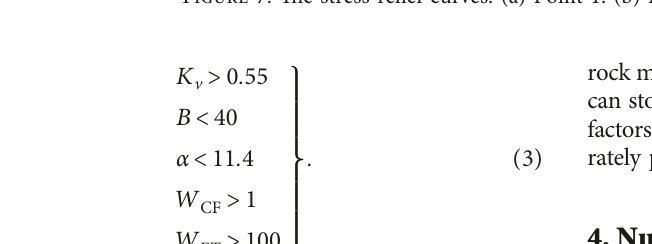
Figure 7: The stress relief curves. (a) Point 1. (b) Point 2. (c) Point 3. (d) Point